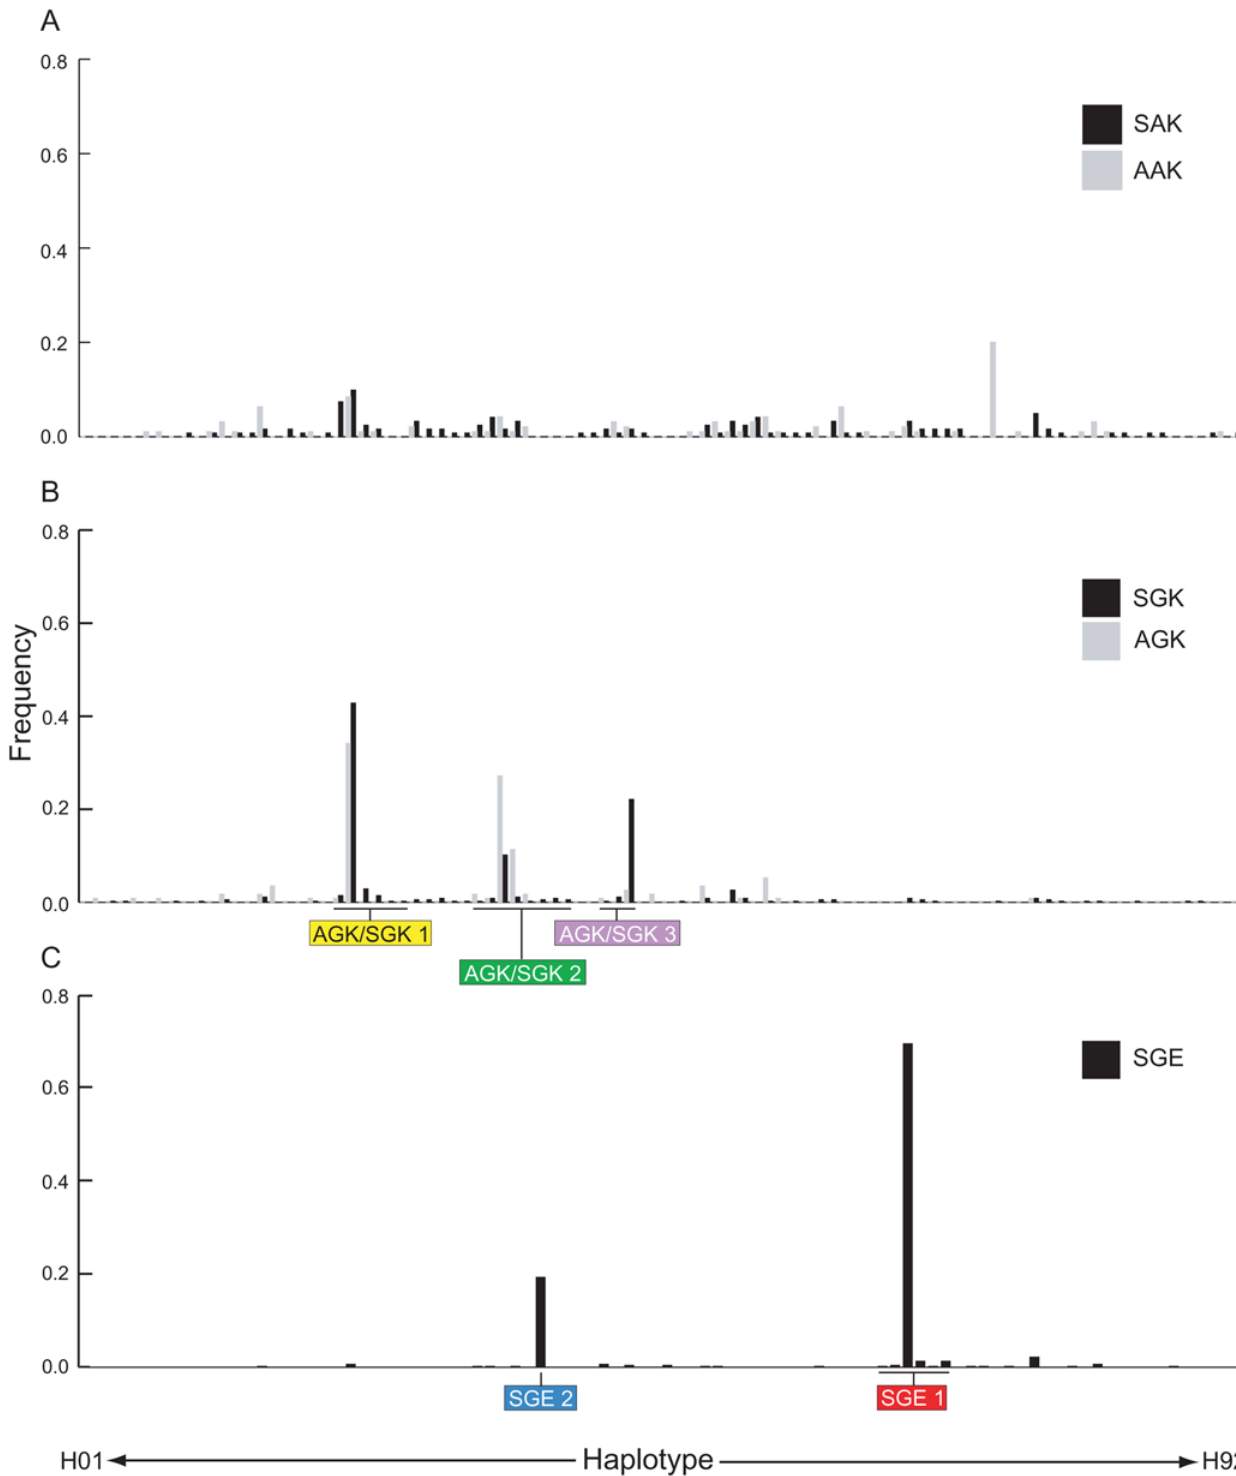
Figure 4. Microsatellite polymorphism flanking wild-type and resistant dhps alleles. In the bar graphs all the microsatellite haplotypes observed have been ranked first according to allele size at locus 0.8 kb and then by allele size at locus 4.3 kb along a common x -axis. The association of specific microsatellite haplotypes with different dhps alleles is apparent from the frequencies of each haplotype shown in the individual charts. (A) haplotypes linked to SAK AAK wild-type alleles, (B) haplotypes linked to AGK SGK single-mutant alleles, and (C) haplotypes linked to SGE double- mutant alleles.